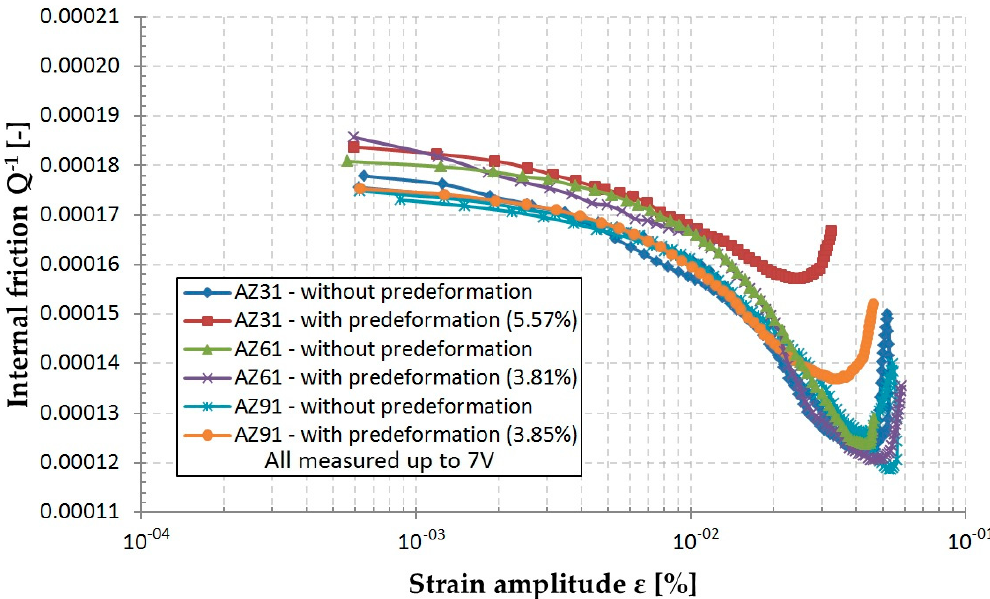
Figure 18. The influence of predeformation on the amplitude dependent internal friction curves.